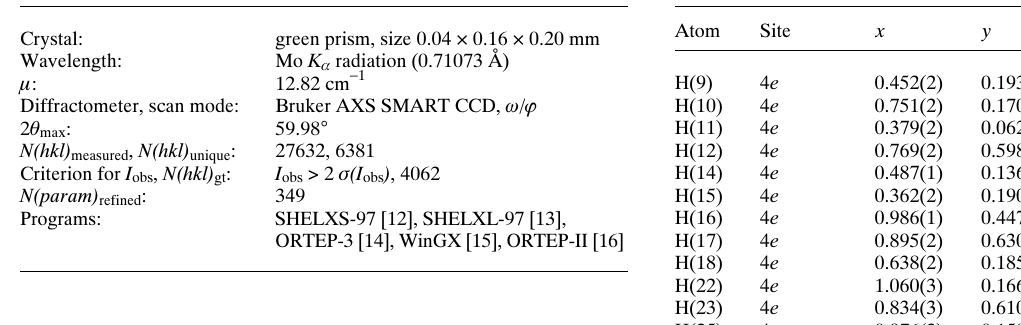
Table 1. Data collection and